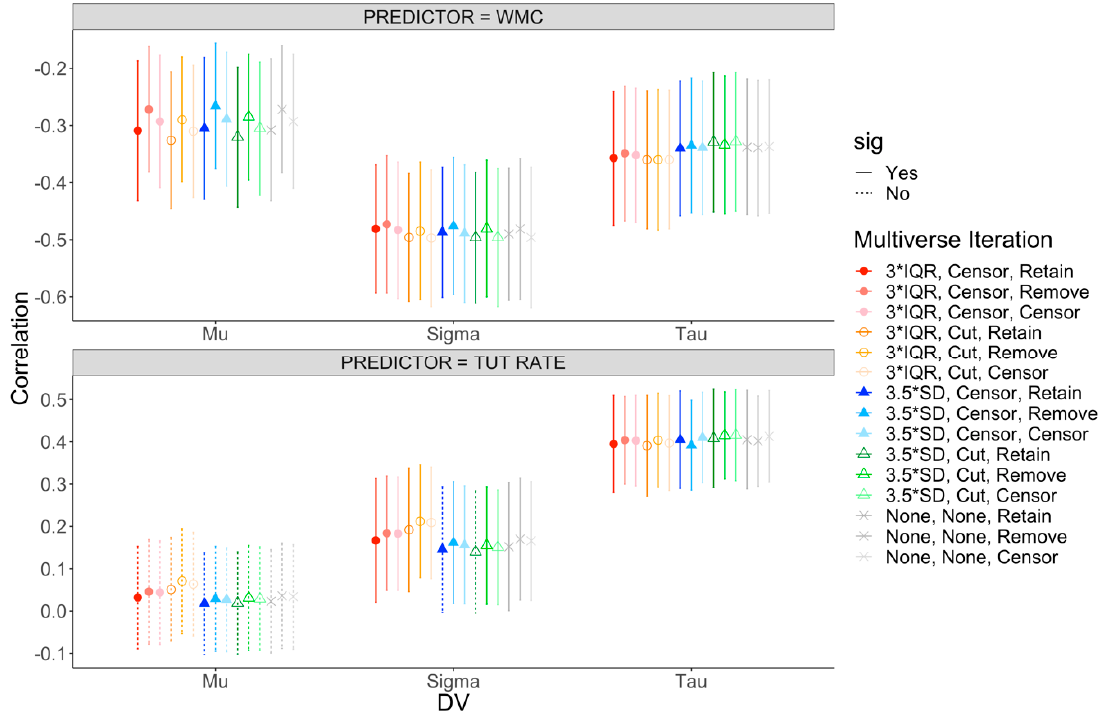
Figure 5. Mini-multiverse of ex-Gaussian correlations. The top panel presents correlations with working memory capacity (WMC). The bottom panel presents correlations with rate of task-unrelated thoughts (TUTs). Points reflect the correlation, with error bars representing the 95% confidence interval (CI) around the estimate. Circles represent iterations where outlying trials were defined by interquartile ranges (IQR), triangles represent iterations where outlying trials were defined by standard deviations (SDs), and xs represent iterations where no criteria were applied to outlying trials. Filled shapes reflect iterations where outlying trials were censored to the respective cutoff value before aggregating and open shapes reflect iterations where outlying trials were removed before aggregating. Colors presented in this figure match those illustrating the multiverse iterations in Figure 3. Solid CIs represent significant correlations, and dashed CIs represent non-significant correlations at p = 0.05.